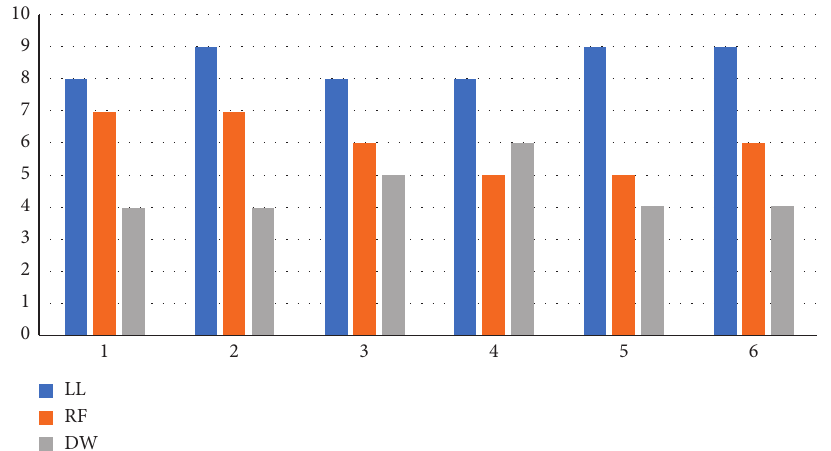
Figure 5: The credibility of the dynamic characteristics of the three different